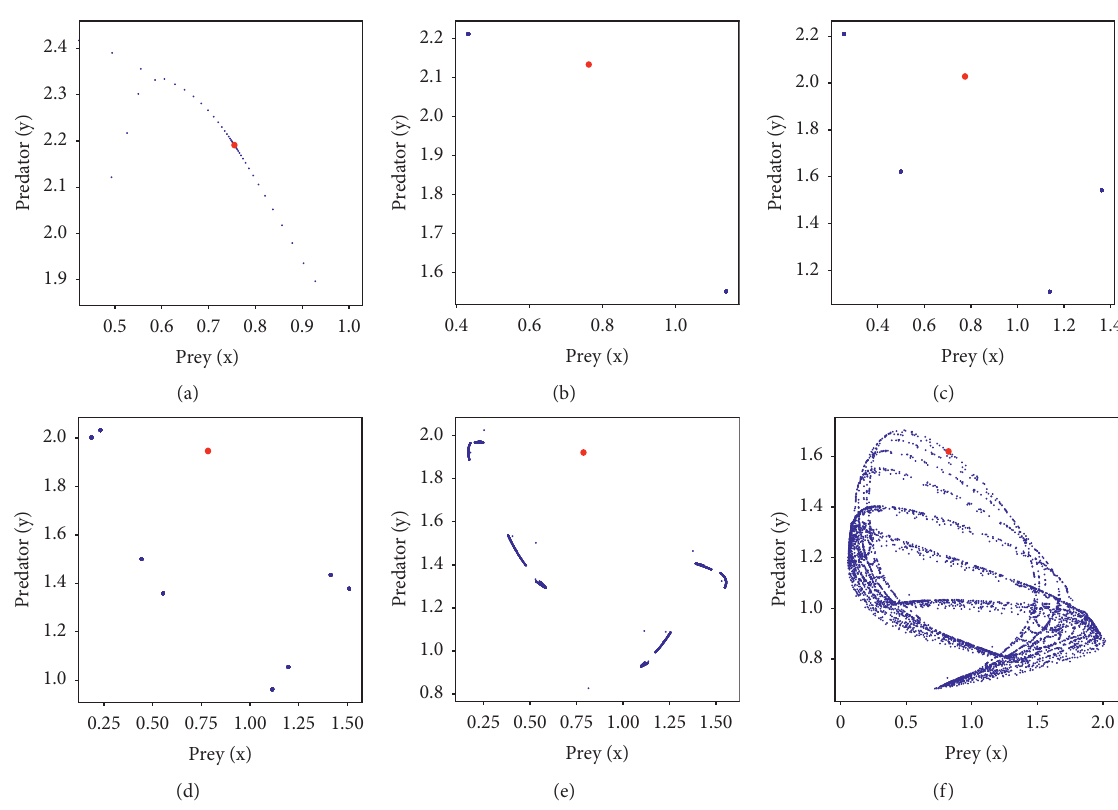
Figure 2: The phase portraits for system (5) with r � 3 . 3, a � 3 . 3, g � 1 . 2, b � 2 . 5, r � 1, h � 0 . 525, and c � 0 . 5 (a) locally stable for 1 2 m � 0 . 2, (b) period-2 for m � 0 . 27, (c) period-4 for m � 0 . 4, (d) period-8 for m � 0 . 5, (e) 8-chaotic like attractor for m � 0 . 53, and (f) chaotic attractor for m � 0 . 9. The red points represent the interior equilibrium point E ∗ ( x ∗ , y ∗ ) , and its values are given in Table 1.